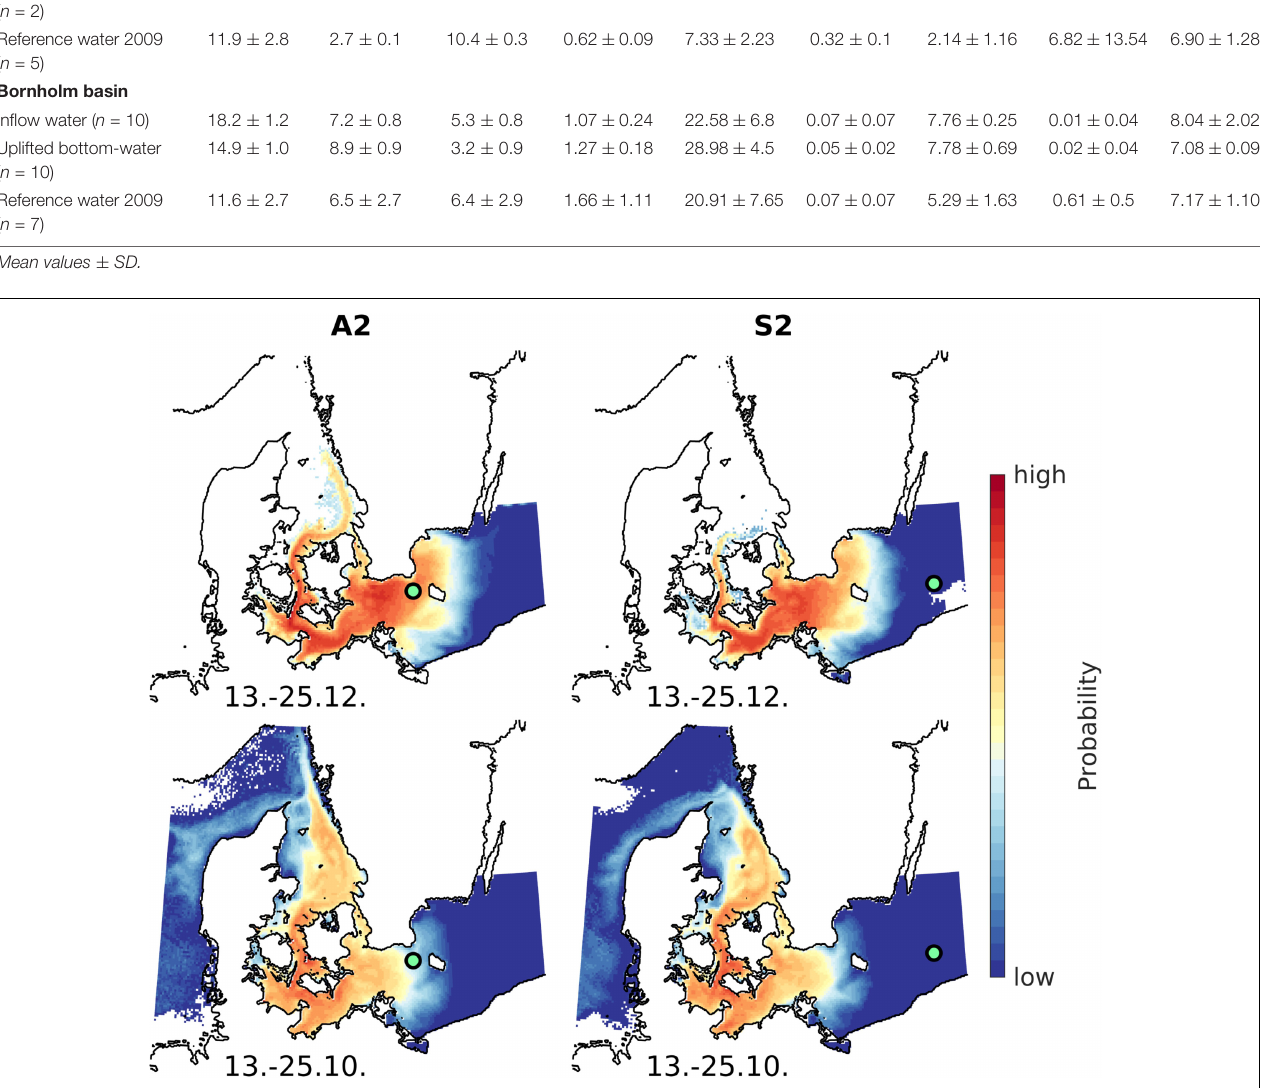
FIGURE 4 | The possible origin of the sampled inflow water in the Bornholm Gat (TFO145, left panels) and in the Slupsk Channel (TFO222, right panels) for two different time slices (upper panels: during the inflow; lower panels: 2 months prior to the inflow). The maps show the most likely origin and were estimated based on numerical